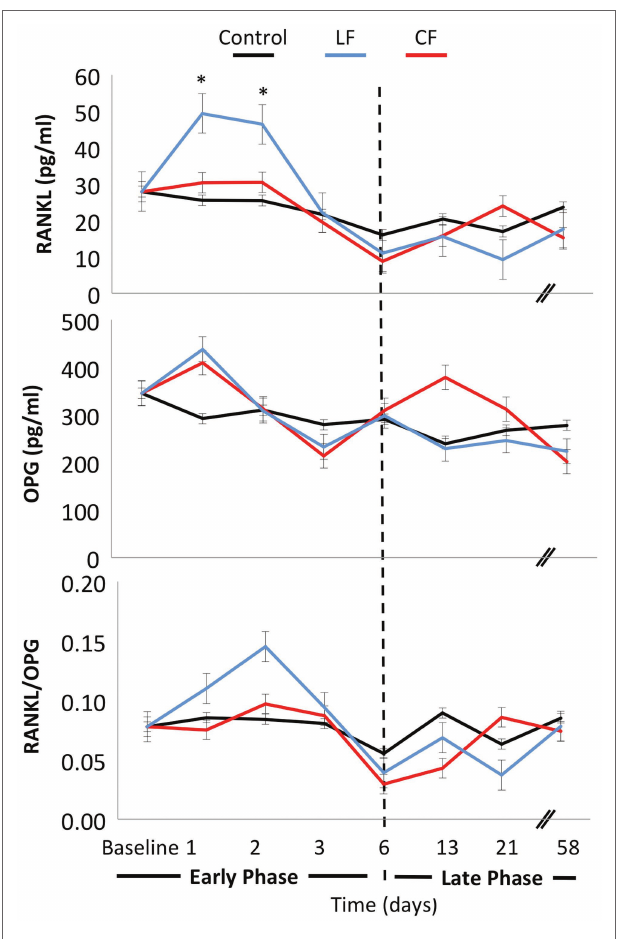
FIGURE 3 | Mean concentrations of the bone markers OPG and sRANKL were measured at day 0, day 1, day 2, day 3, day 6, day 13, day 21, and day 58. The ratio sRANKL/OPG was calculated for each day. Both conventional and low force had an impact on sRANKL and OPG levels. In the early phase, a peak of soluble RANKL concentration was measured on days 1 and 2 in the low-force group. In the late phase from day 6 on, the levels stayed constant. No significant differences were measured for sRANKL/OPG concentrations over time or between force groups.